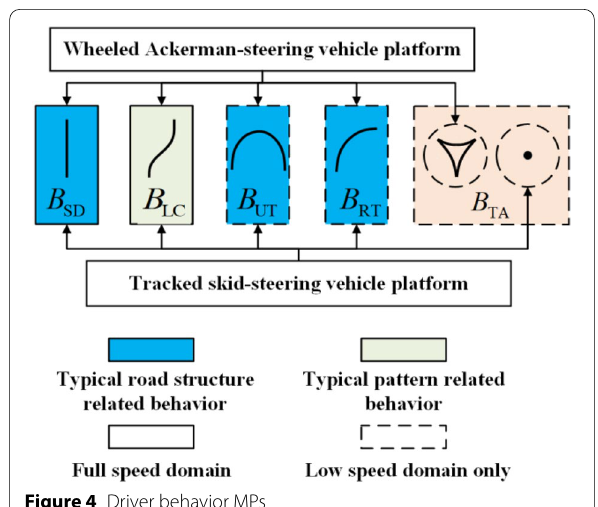
Figure 4 Driver behavior